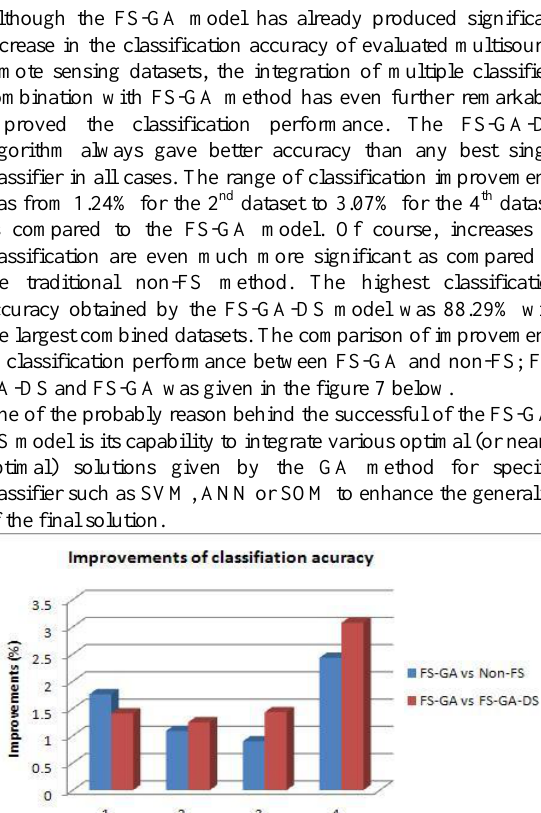
Figure 6. Comparison of best classification results of non-FS, FS-GA and FS-GA-DS methods on different datasets.